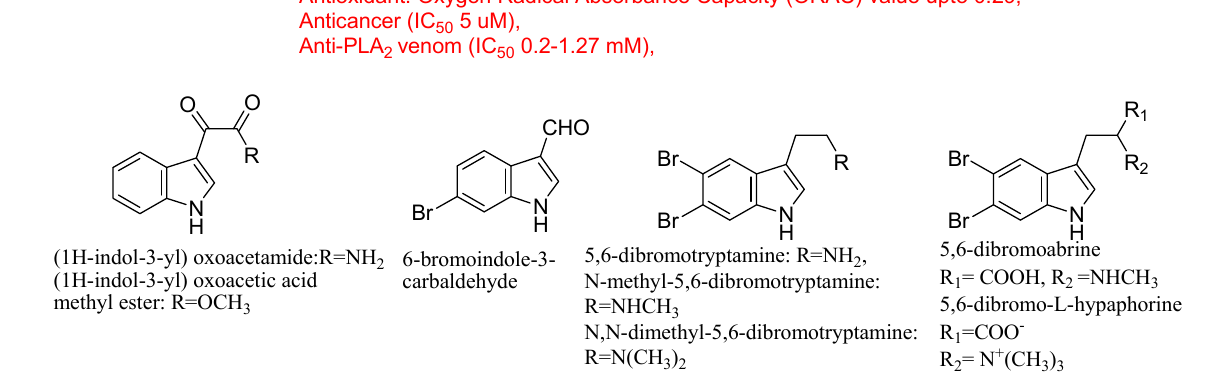
Figure 17. Indoles from